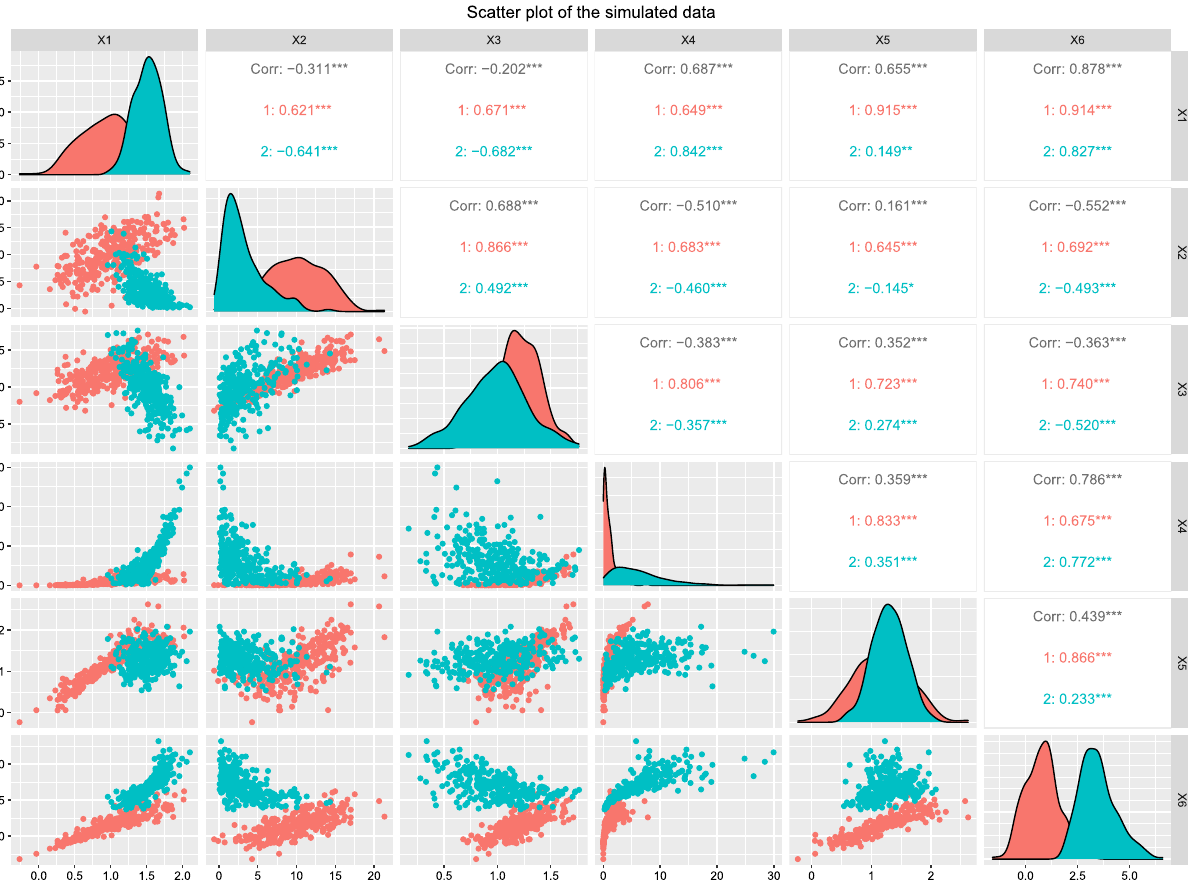
Figure 1. Scatter plot of the simulated